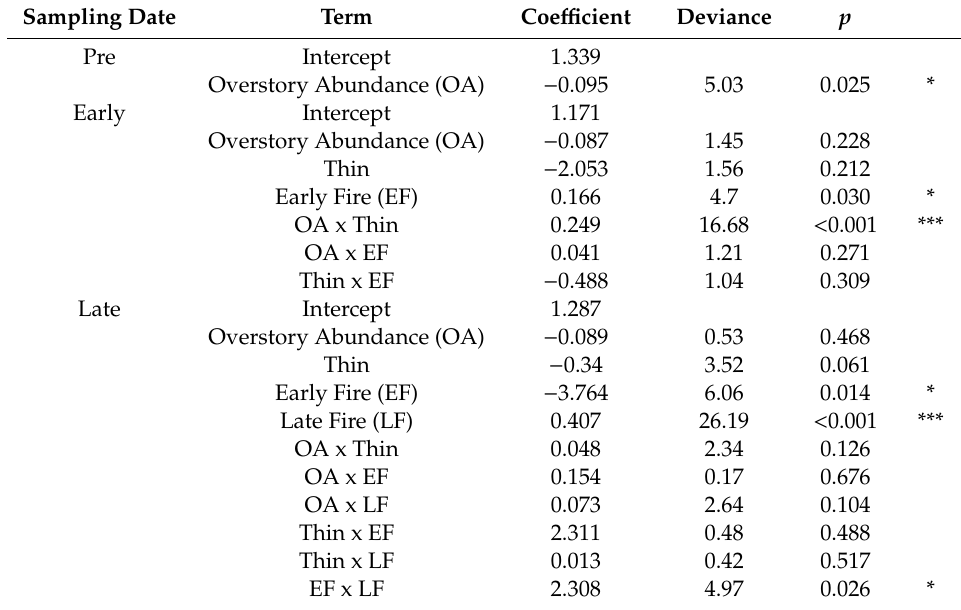
Table A4. Model results for seedling ( < 1 m tall) frequency at each sampling date ( n = 72 plots). Each response was analyzed with a GLM with a negative binomial distribution. Total deviance was 73.76, 112.65, and 125.79 for the Pre, Early, and Late sampling dates, respectively. Coe ffi cients are not back-transformed to original units. Statistical significance was evaluated using a chi-square test of the deviance explained by the term ( df = 1 for all terms).